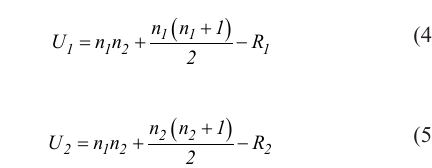
σ β= σ = + is large, the 0